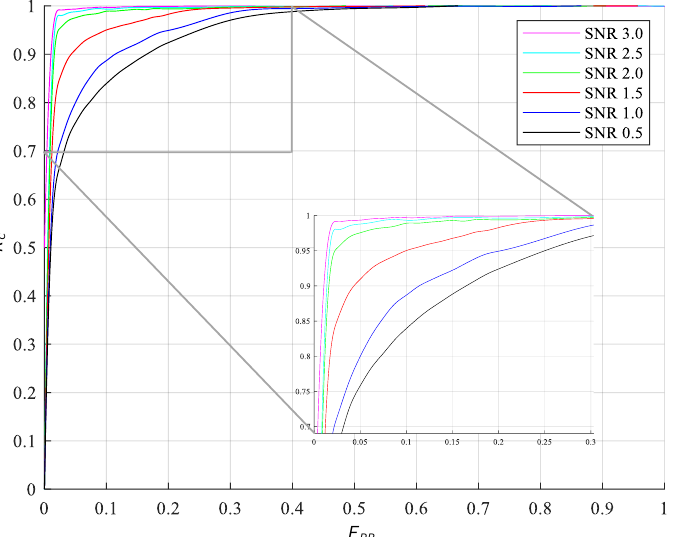
Figure 10. The ROC curves of proposed using different SNRs.